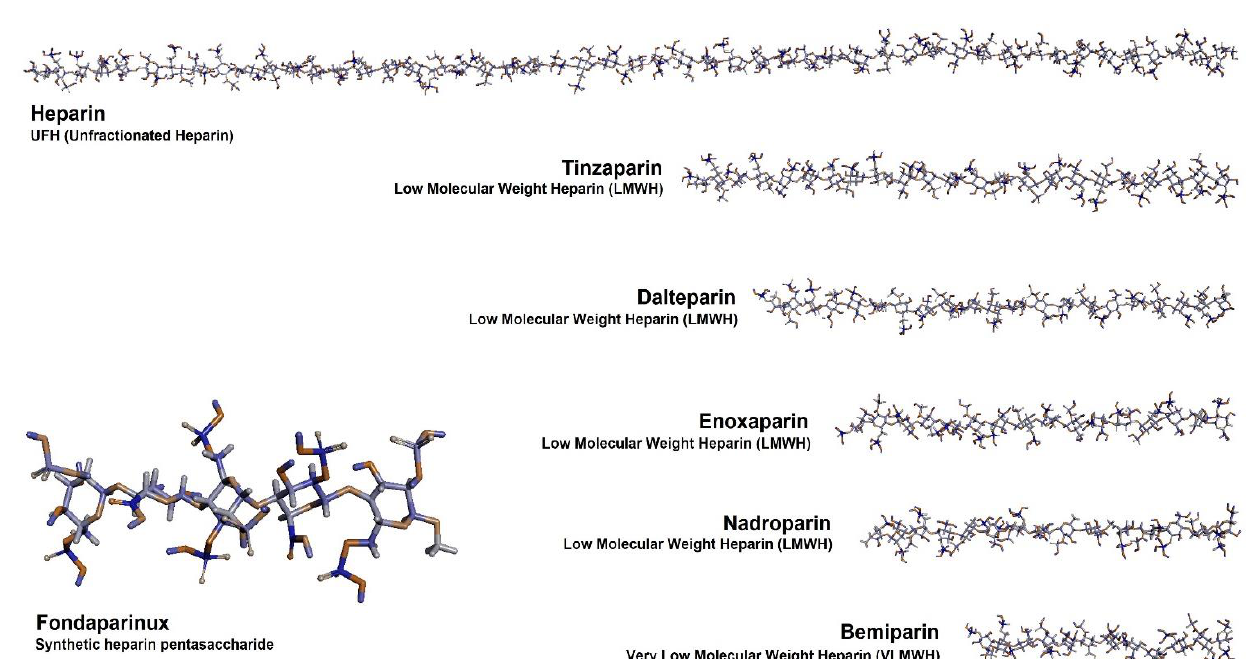
Figure 2. Chemical structures of unfractionated heparin (UFH), low-molecular-weight heparin (LMWH), very-low-molecular-weight heparin (VLMWH), and synthetic heparin pentasaccharide used as anticoagulants. Based on the main sequence of heparin, the molecular structure of heparin was specified through computer simulation to consider the molecular interaction with heparin related proteins. The molecules were generated from the solution structures of heparin obtained using an X-ray scattering model (protein data bank; PDB, 3IRL) [38]. The molecular structures of heparin were further modified using the ChemDraw 20.1 Professional (PerkinElmer) program based on their synthetic processes and average molecular sizes. The modified molecules were visualized using the Discovery Studio 2021 (BIOVIA) software.